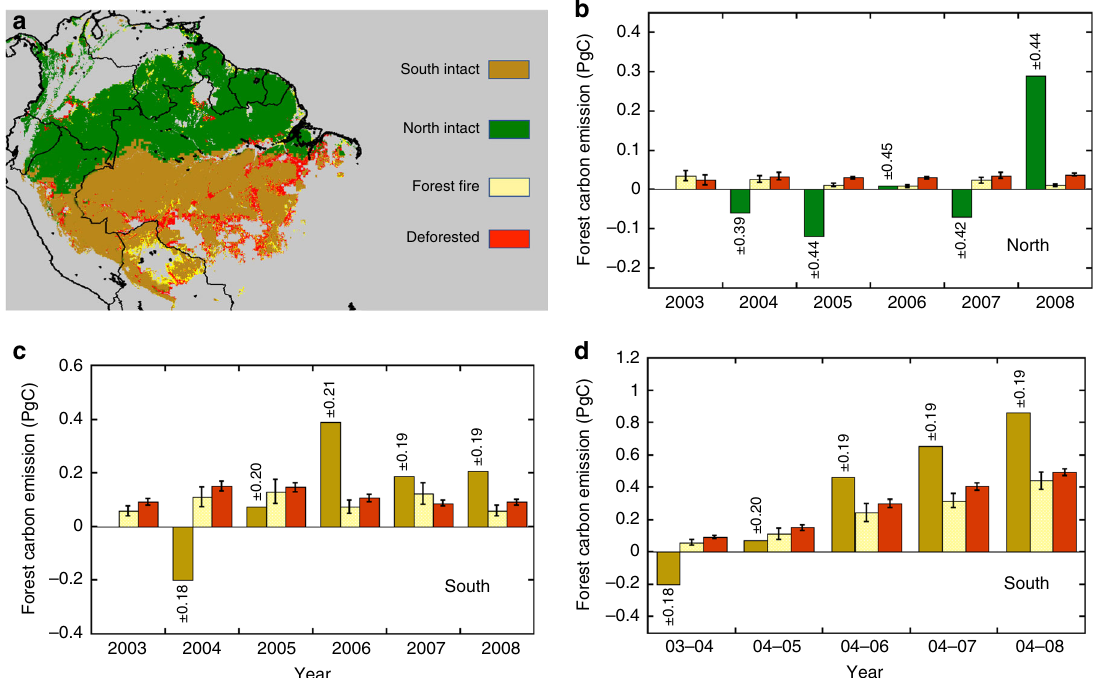
Fig. 3 Net carbon change and emissions from fi re and deforestation. a Classi fi cation map showing pixels with intact Amazon forests belonging to South and North, as well as fi re and deforestation activities in tropical forests. b Annual contributions of fi re and deforestation emissions compared to the net forest carbon change in the North region. c Annual contributions of fi re and deforestation emissions compared to the net carbon change in the South region. d Cumulative contributions of net forest carbon change, fi re and deforestation emissions in the South relative to the 2004 level. The colormap in panel a was generated using rainfall 82 , MODIS fi re 50 and Landsat 51 products. Pixels were identi fi ed as fi re or deforested when at least 1% of these land-use activities were detected during our observational period. In panels b - d , the positive sign indicates carbon emission to the atmosphere, and negative emission refers to carbon sink. The error bars in estimating emissions are at 95% con fi dence